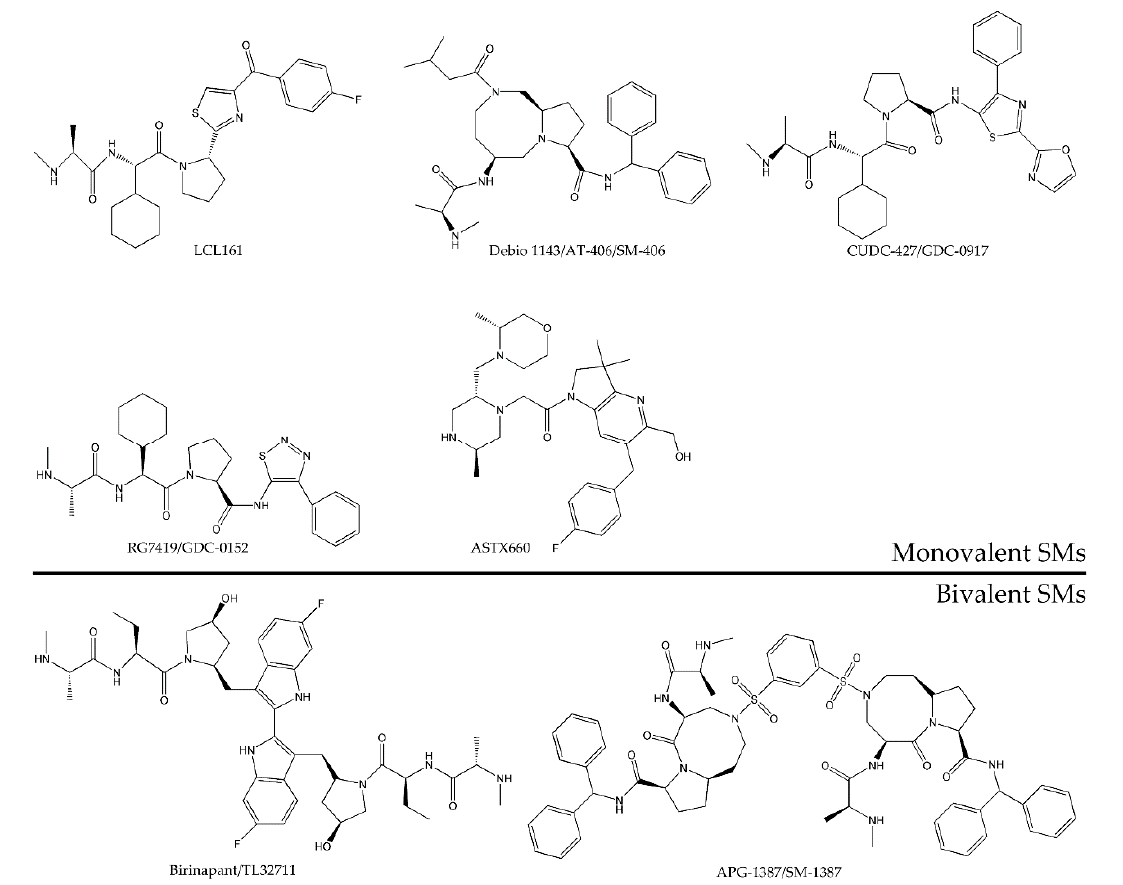
Figure 5. Chemical structure of monovalent and bivalent SMs tested in completed or ongoing clinical trials as anticancer agents.